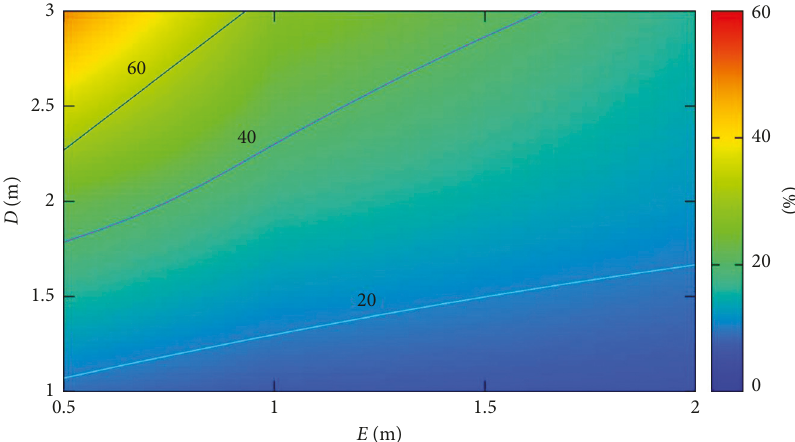
Figure 10: Percentage of affected area spectrum versus the investigated parameters for the “meandering”